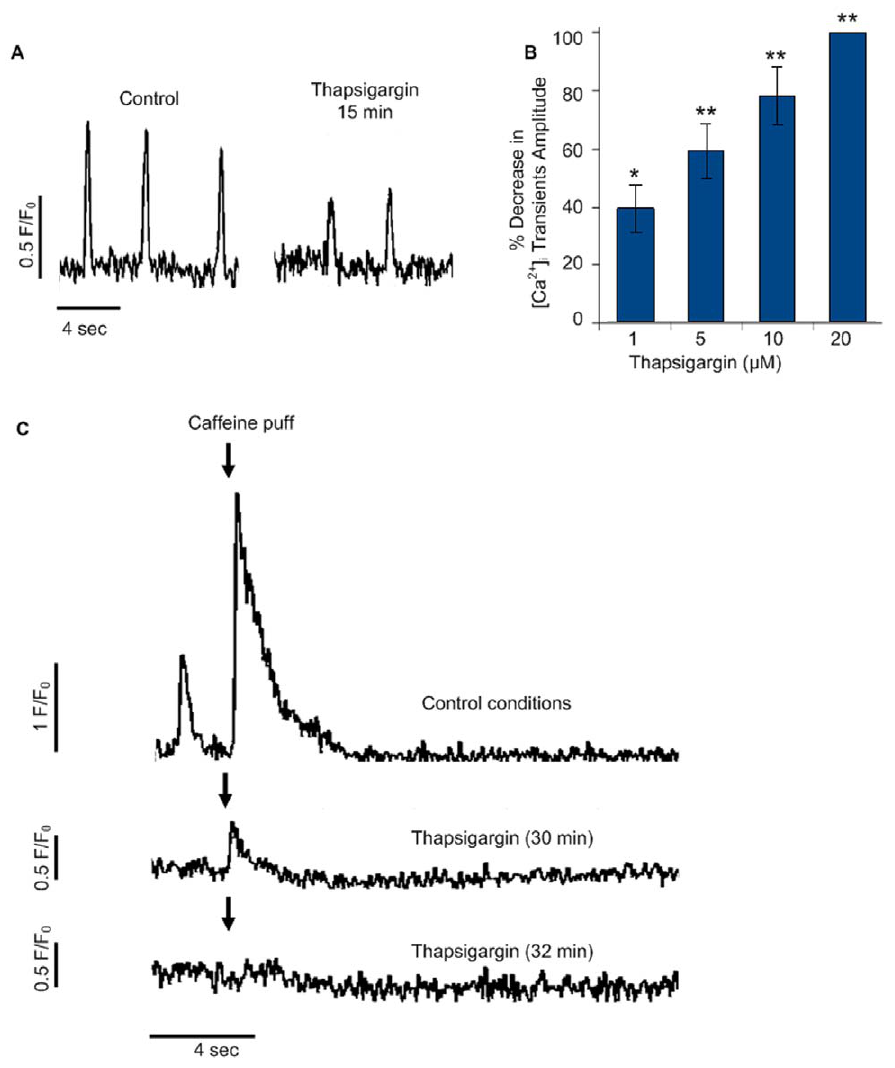
Figure 5. The effects of SERCA inhibition. ( A ) Line-scan tracings of whole-cell [Ca 2 + ] i transients in a hIH1 hiPSC-CM under control conditions (left) and after 15 minutes (right) of continuous 10 m M thapsigargin exposure. ( B ) Dose-response effects of thapsigargin (1, 5, 10 and 20 m M) on [Ca 2 + ] i transients amplitude (displayed as percentage decrease versus baseline values). *p , 0.05 and **p , 0.01 when mean absolute values were compared to baseline values. ( C ) Caffeine-induced Ca 2 + transients (denoted by arrows) under control conditions (upper), after 30 minutes (middle), and 32 minutes (lower) of thapsigargin exposure. Abbreviations: F/Fo, fluorescence (F) normalized to baseline fluorescence (Fo); sec, seconds.